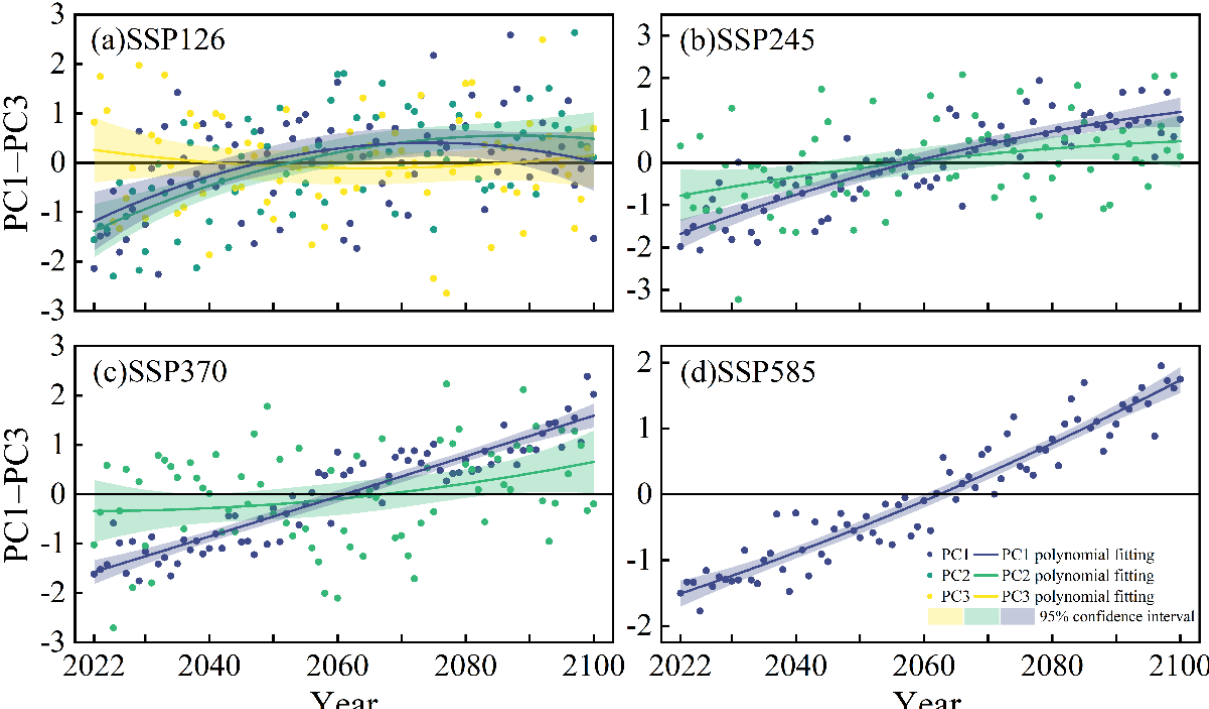
Figure 11. Principal component time coefficients (PC1–PC3) and their polynomial fits for the EOF analysis of future ET 0 in the Yellow River Basin under four emission scenarios (( a ) SSP126, ( b ) SSP245, ( c ) SSP370, and ( d ) SSP585).